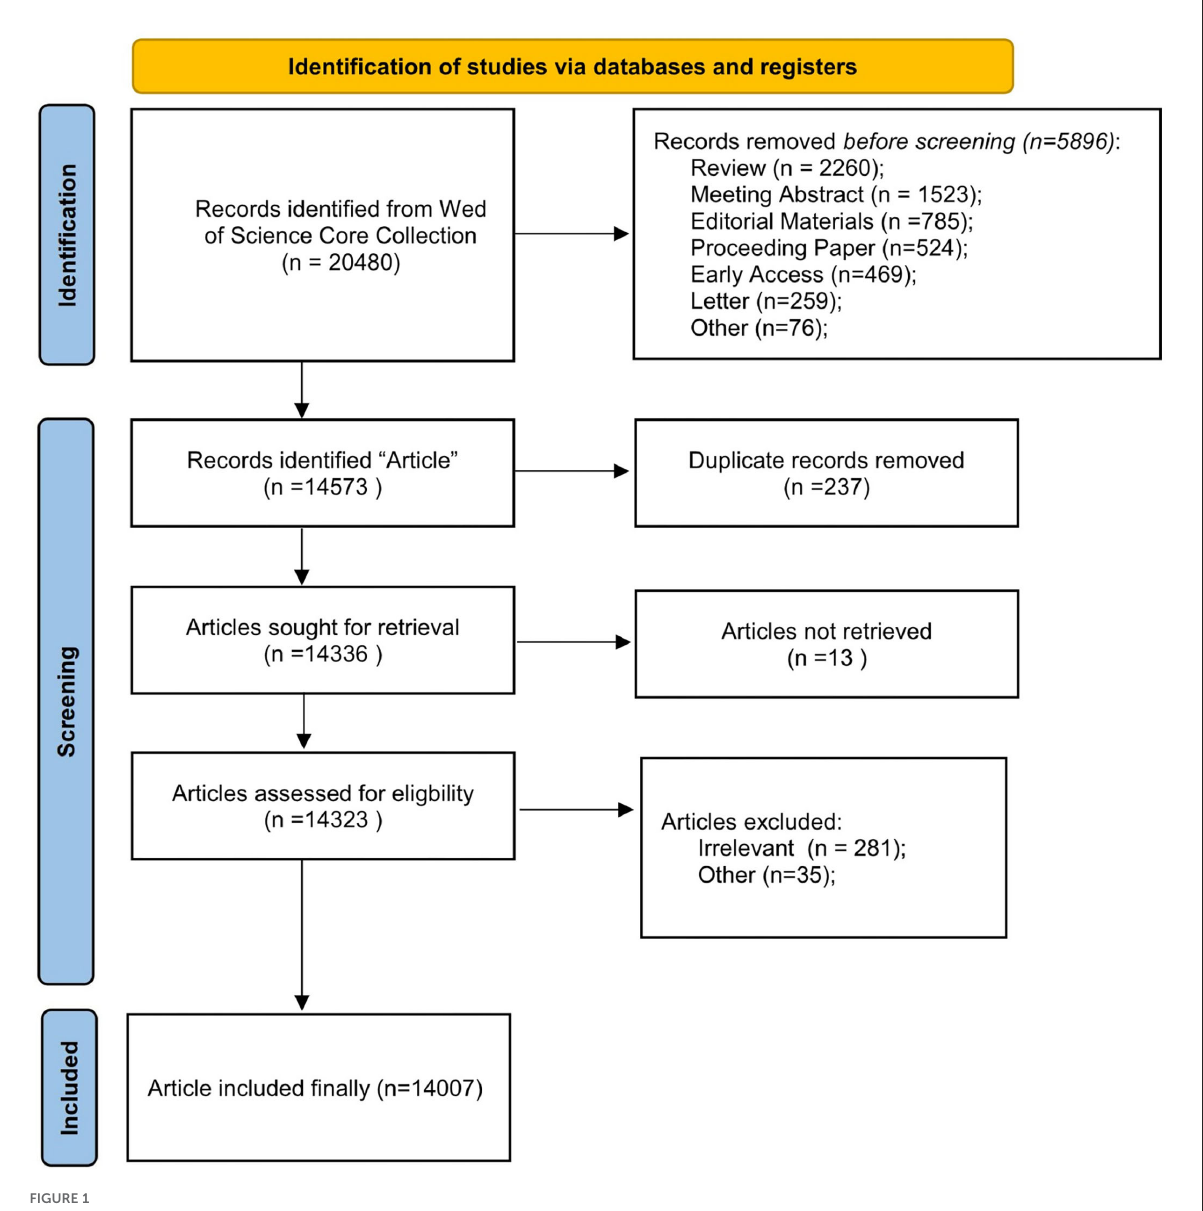
FIGURE1 The flowchart of included and excluded